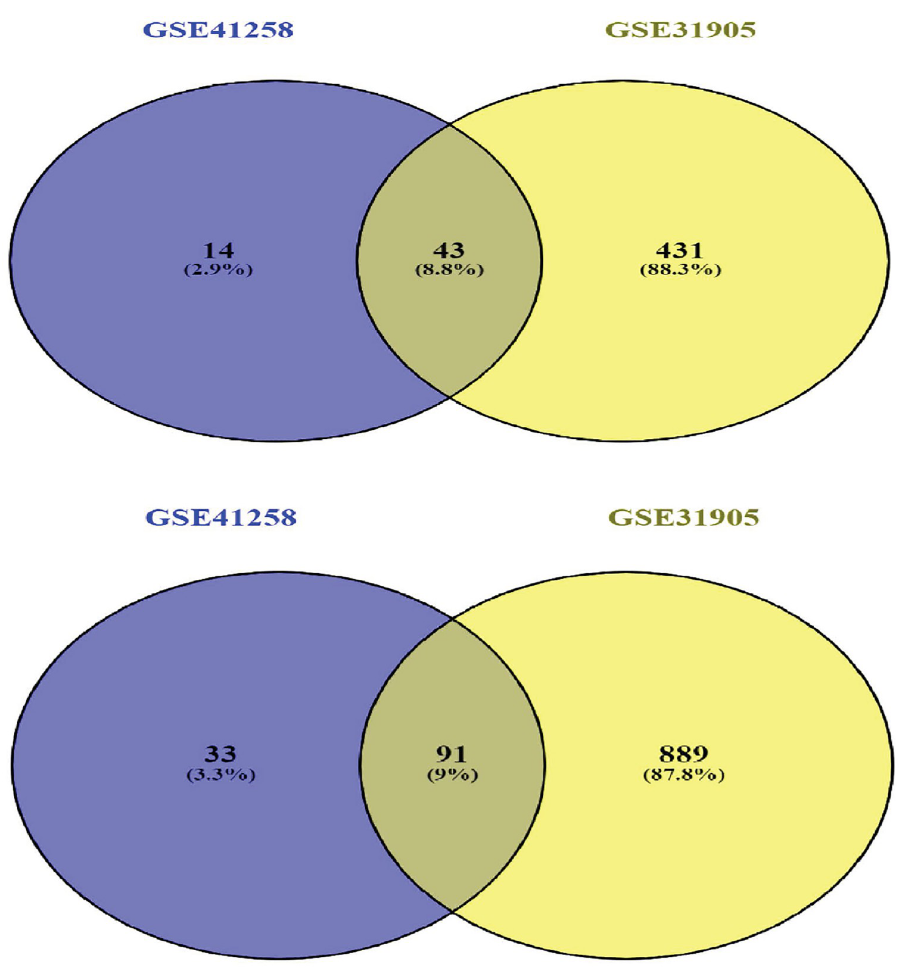
Fig 4. Venn diagrams illustrating the number of validated Differentially Expressed Genes (vDEGs). Top) Over- expressed DEGs. Bottom) Under-expressed DEGs.